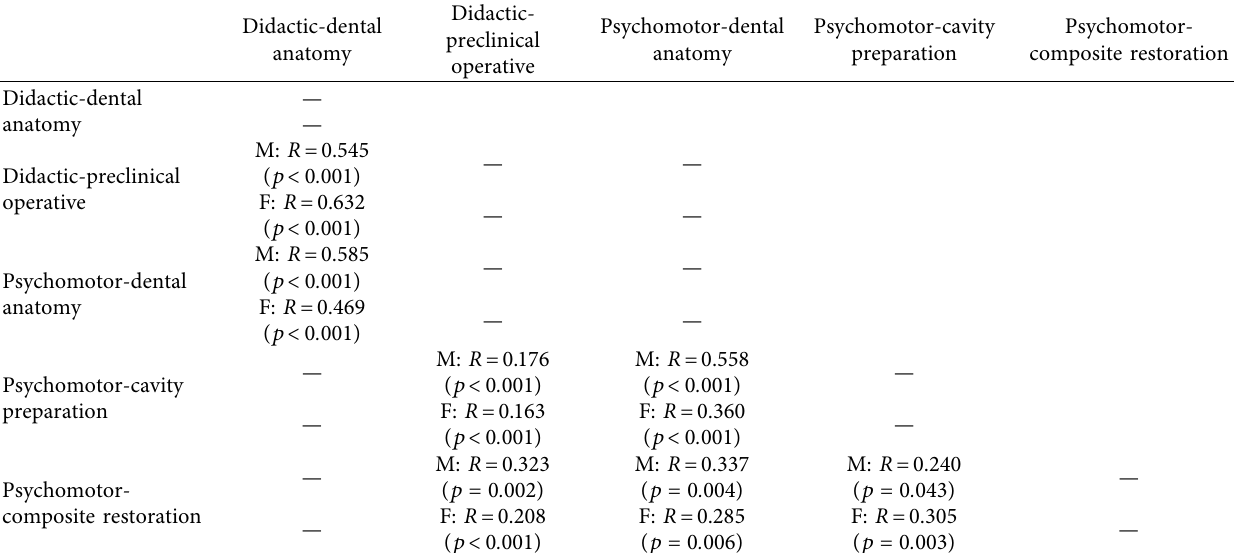
Table 2: Pearson’s correlation matrix and p values of dental anatomy and preclinical operative dentistry didactic percentage scores with psychomotor skills percentage scores for male (M) and female (F) dental